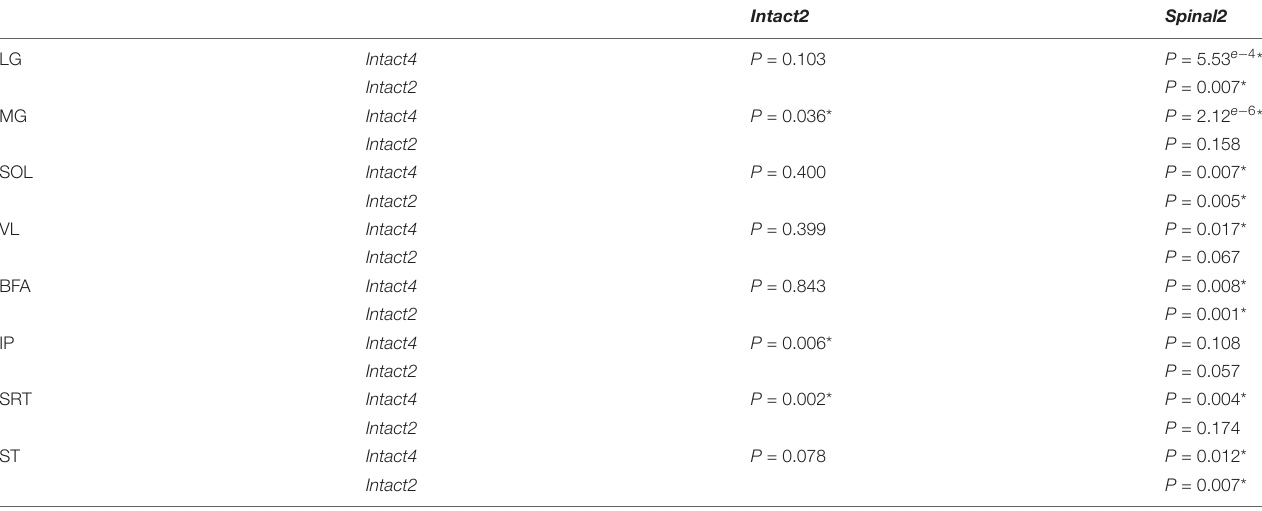
TABLE 1 | Effect of locomotor condition and state on EMG burst